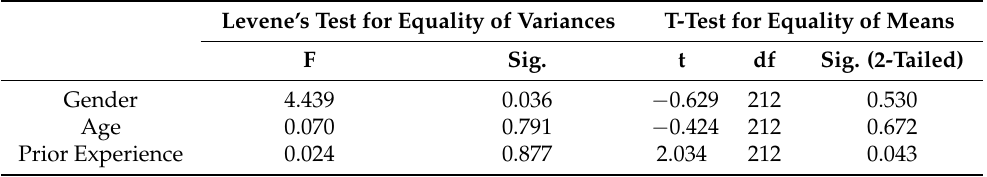
Table 2. Levene’s test for equality of variances and T-test for equality of means. Levene’s Test for Equality of Variances T-Test for Equality of Means